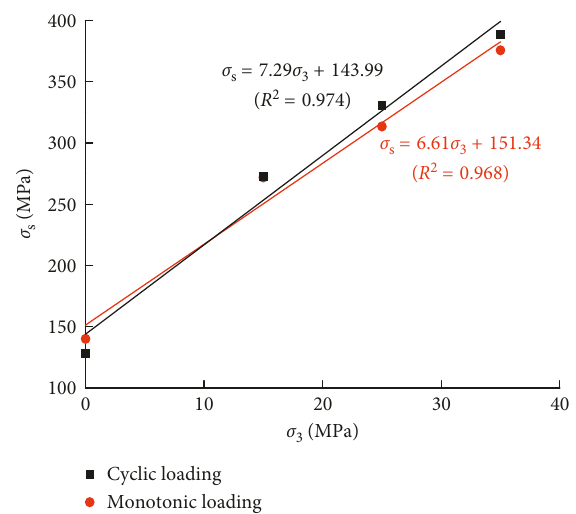
Figure 8: Comparison of peak strengths between monotonic and cyclic loading.